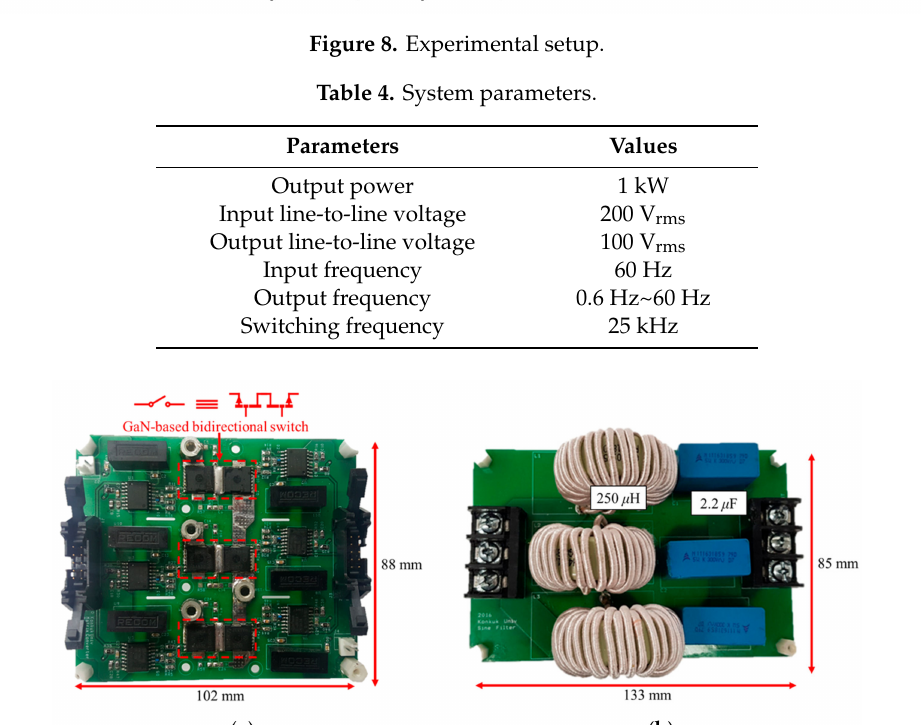
Figure 9. Photograph of ( a ) GaN-based VFD using matrix converter and ( b ) sine wave